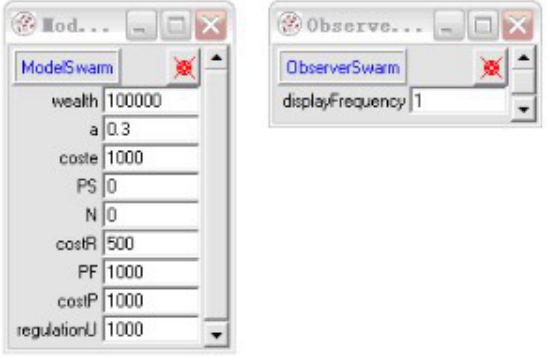
Figure 4. The dialog box for parameters